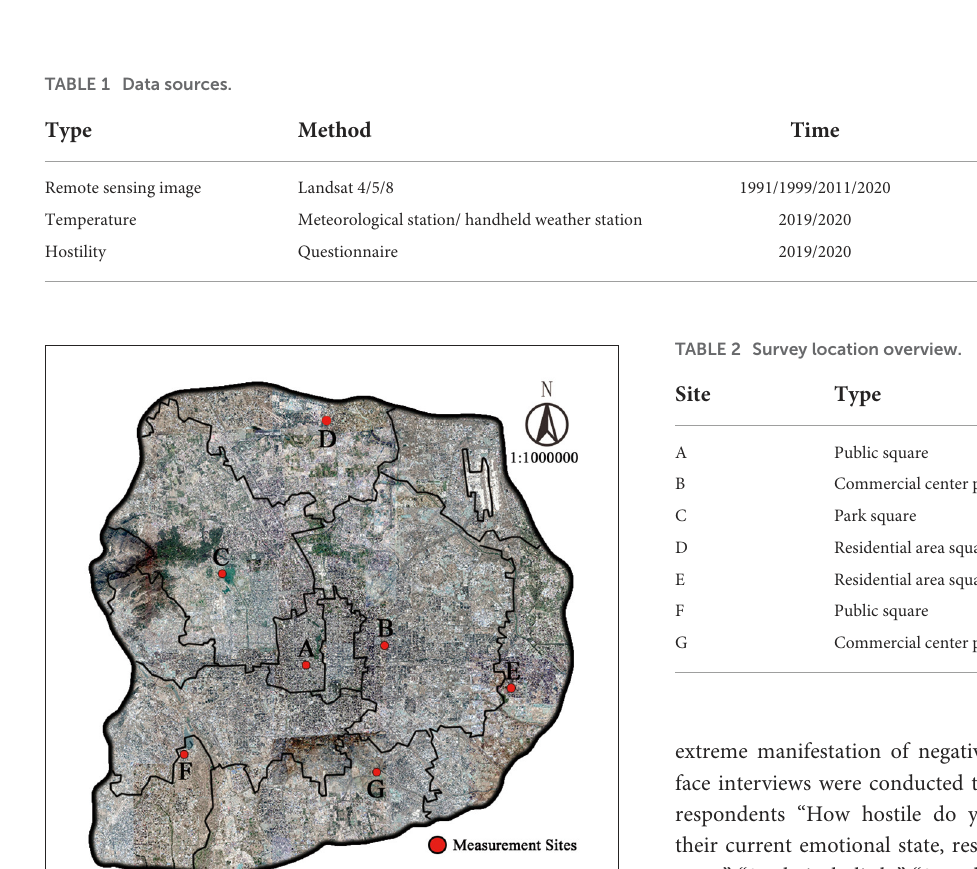
FIGURE2 Measurement